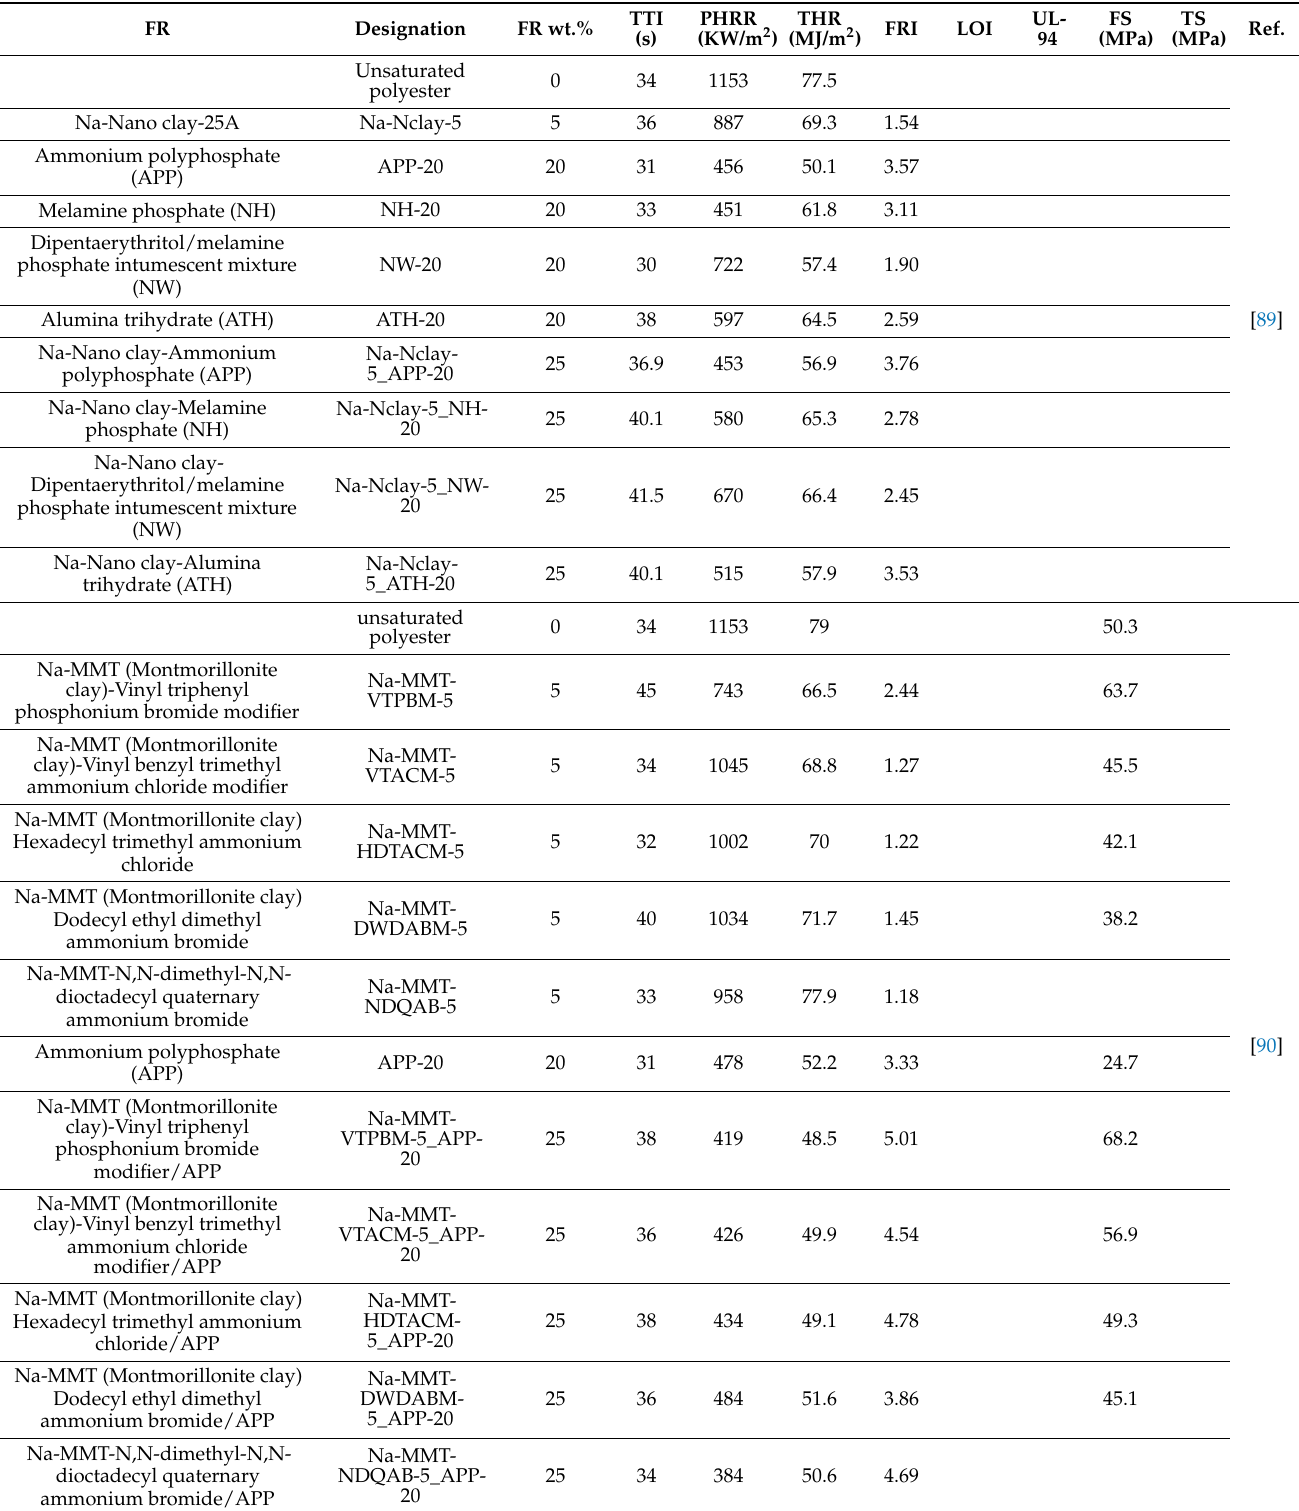
Table 5. Cone colorimetry data (TTI, PHRR, THR), calculated FRI value, LOI, UL-94, FS and TS for unsaturated polyester filled with a wide variety of FR. The designation in the second column refers to FR type followed by wt.% of